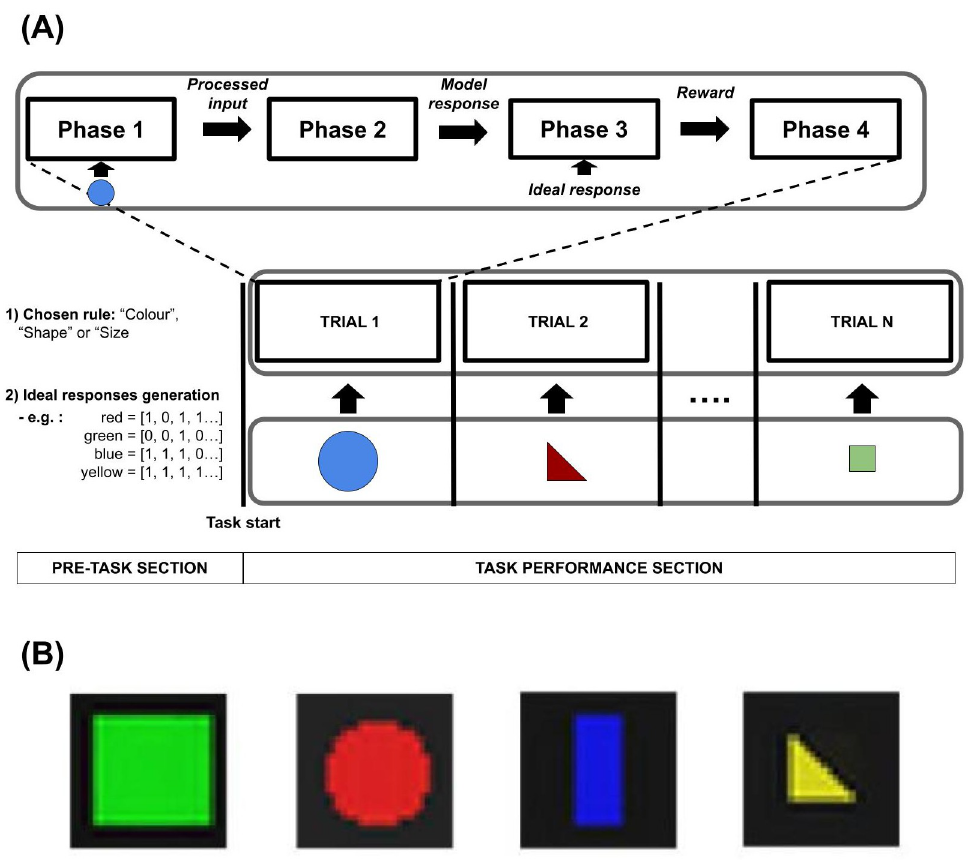
Fig 1. (A): Scheme of the task protocol. The row below shows the examples of inputs that the environment provides to the model (visual input). The middle row shows the trial sequence. Note that a first experimental section occurs before the task experimental section with trials and involves the setting of the task conditions, that is, the choice of the sorting rule and the creation of the ideal responses. The top row zooms in a specific trial, showing the phases that occur during the model-environment interactions. (B): Examples of the 64 geometrical shapes (circles, squares, rectangles, triangles), used to produce the images. Each image encompasses a different attribute out of the four attributes of each of the three categories, namely shape, colour, and